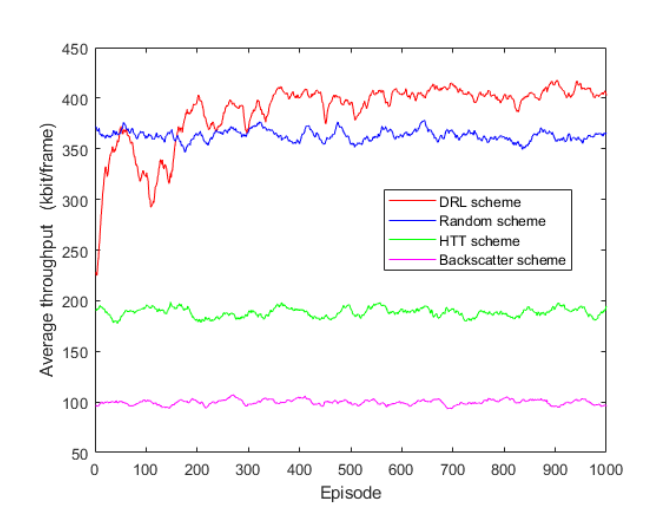
Figure 4. Convergence comparison between proposed DRL scheme and the baseline schemes in large-scale scenarios.